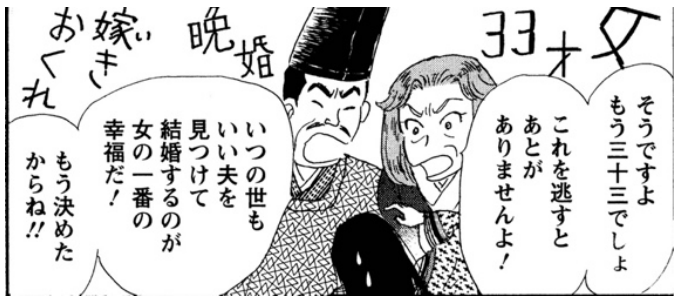
Figure 19. Heroine’s parents try to convince her to get married (Shimizu 2014, 88). Courtesy of